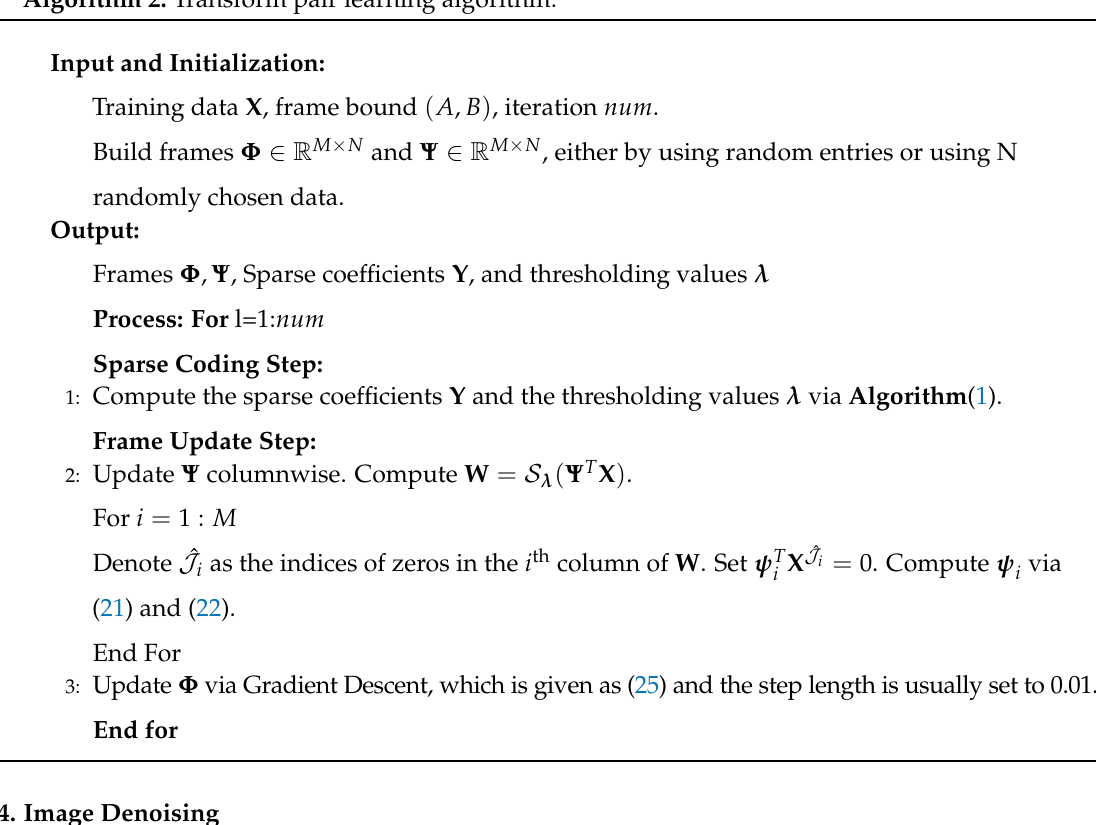
Algorithm 2: Transform pair learning